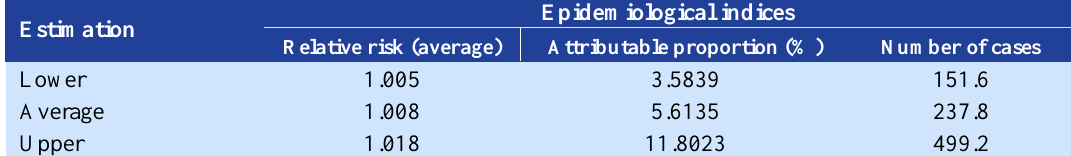
Table 2. The estimation of relative risk indices, attributable proportion, and number of cases of cardiovascular disease mortality (Baseline incidence (BI) = 497) in Kermanshah in 2011 Estimation